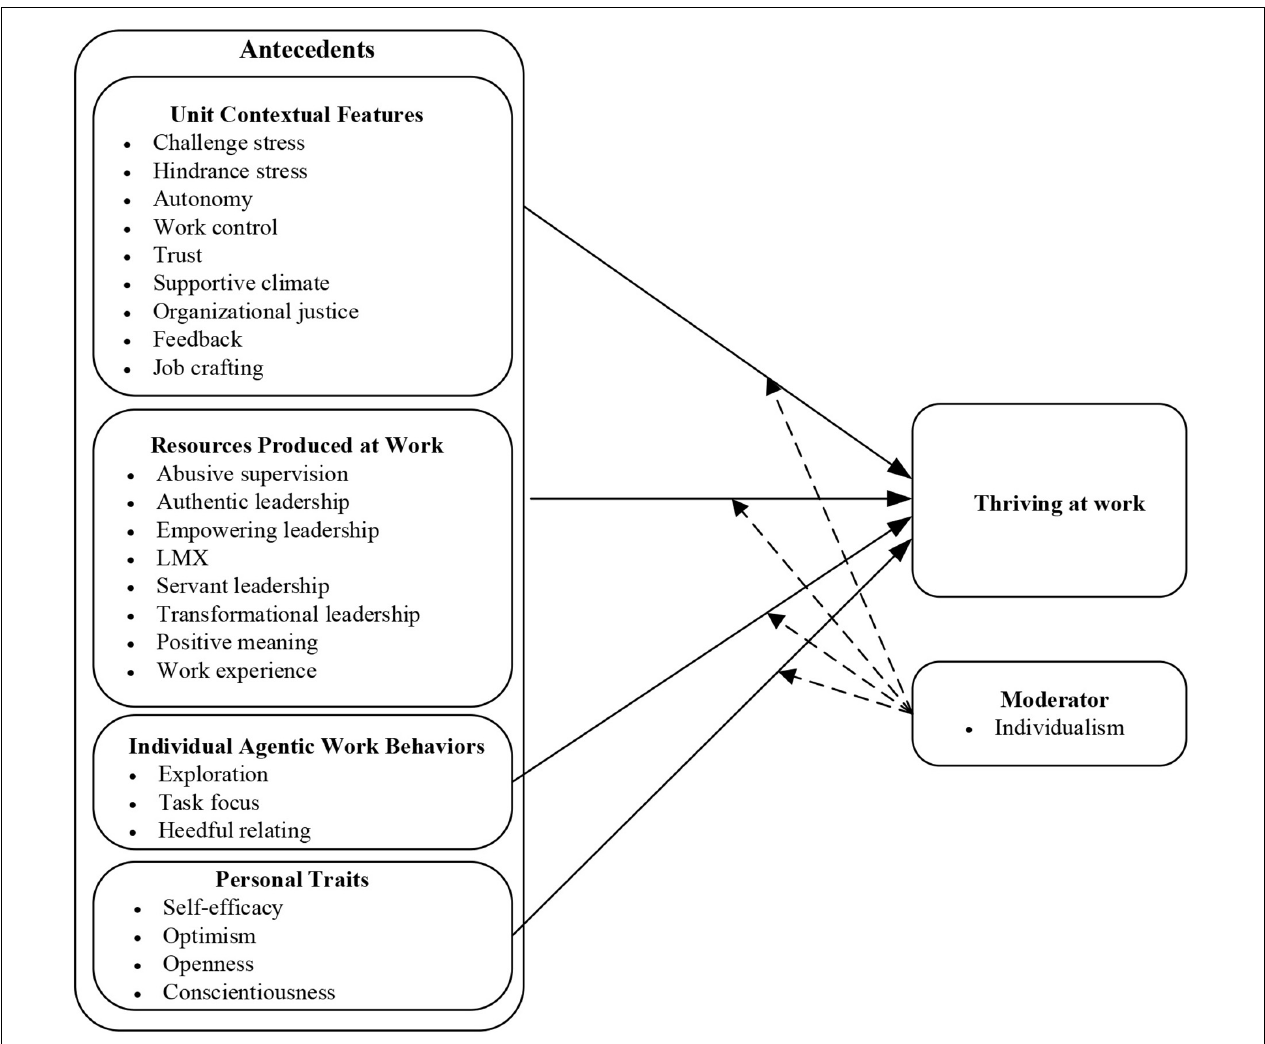
FIGURE 1 | Framework of the